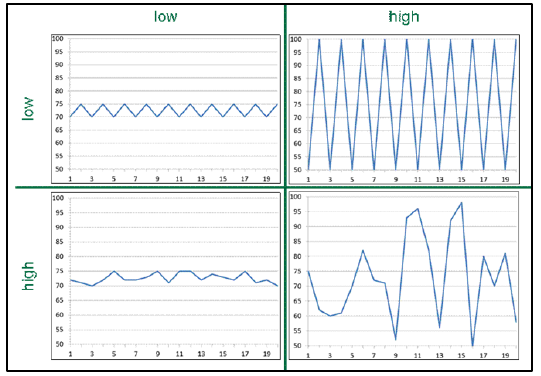
Figure 2. Examples of the interaction of variance and unpredictability